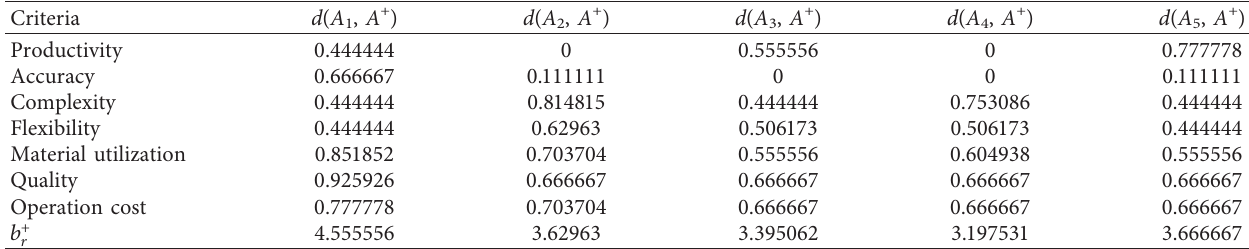
Table 8: Rating of each alternative from A + (PIS).